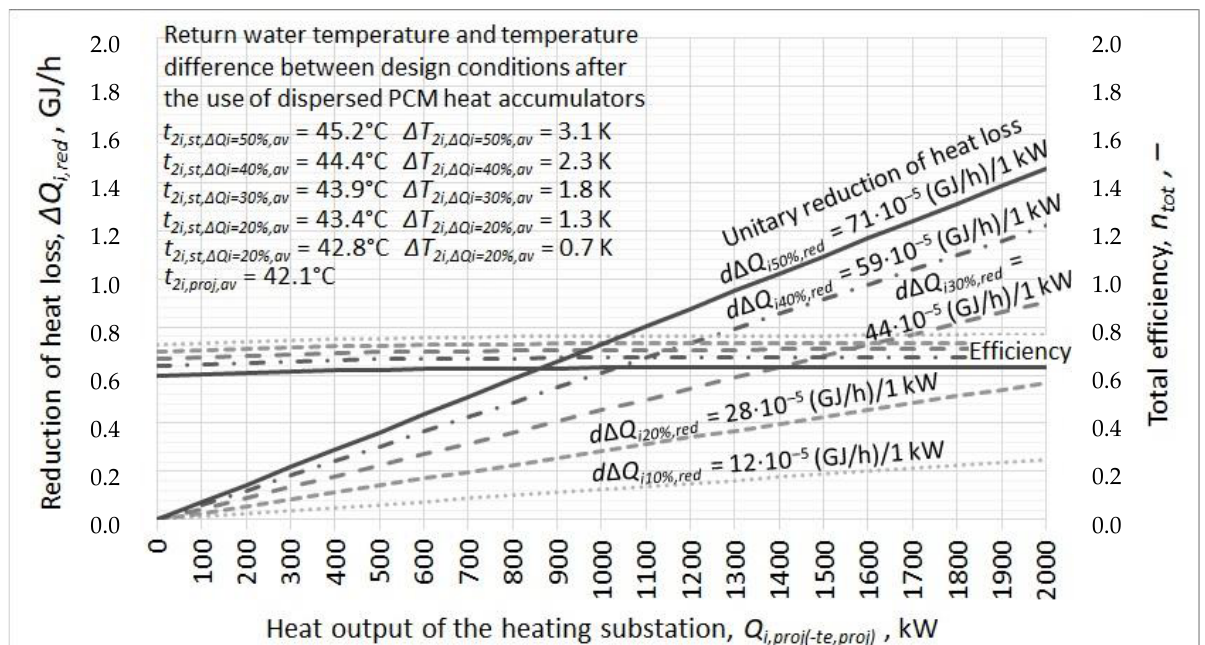
Figure 10 . Reduction in heat loss, regulation of return water temperature, and improvement of efficiency after the application of dispersed PCM heat accumulators .